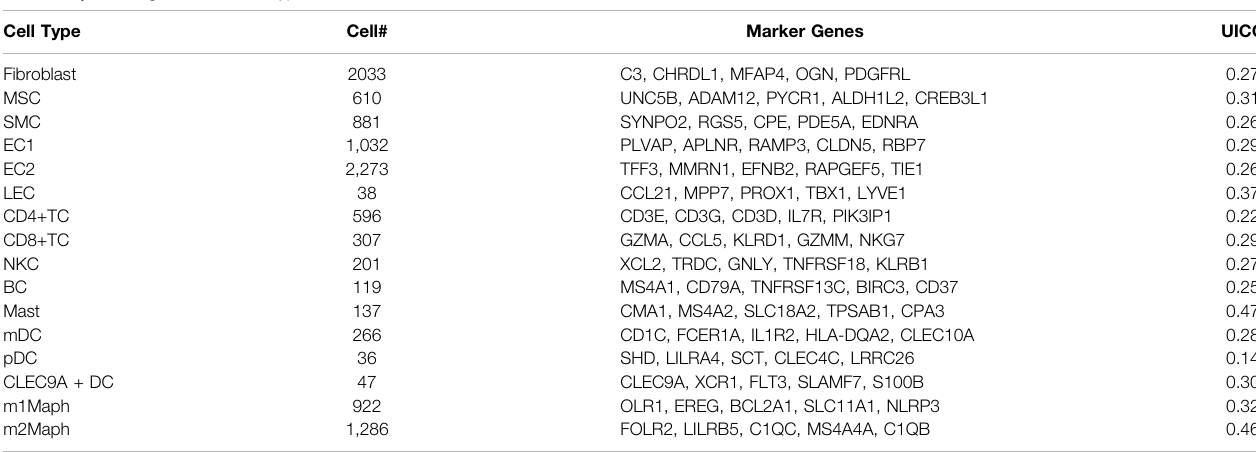
TABLE 1 | Marker genes of 16 cell